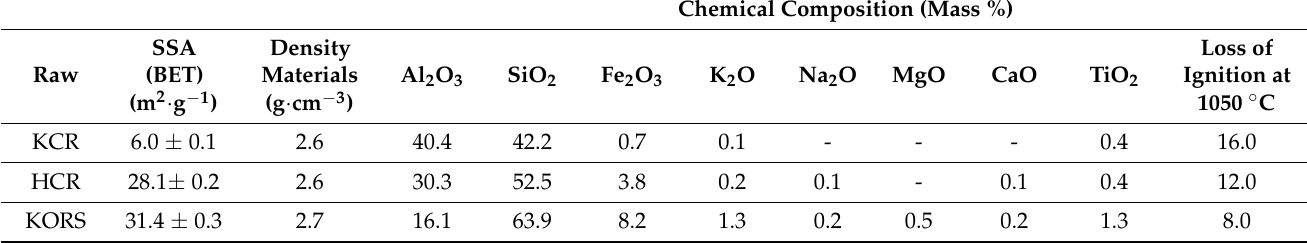
Table 1. Chemical composition (XRF analysis) and other characteristic physical properties of the starting